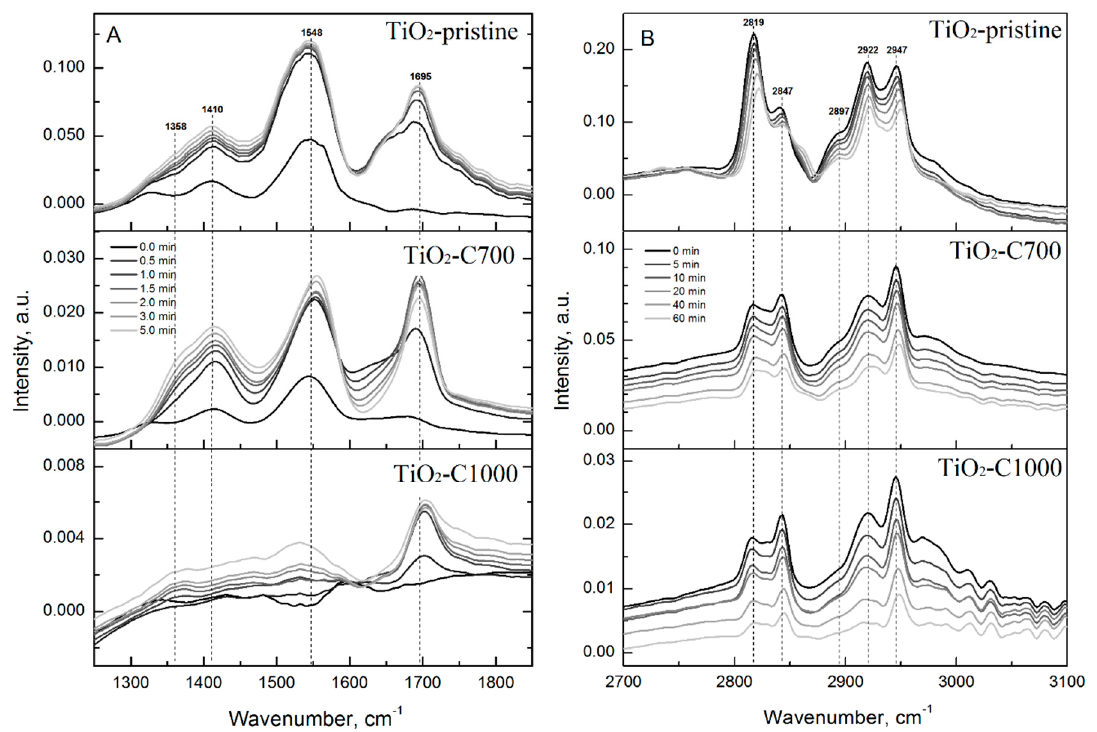
Figure 5. Adsorption of CO 2 ( A ) and desorption of methanol ( B ) on/from the surface of TiO 2 samples.